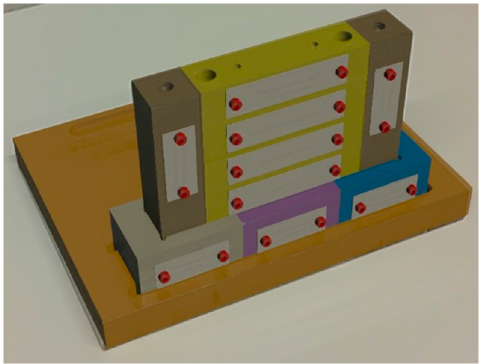
Figure 5. Prepared workstation after calibration of the absolute CS.